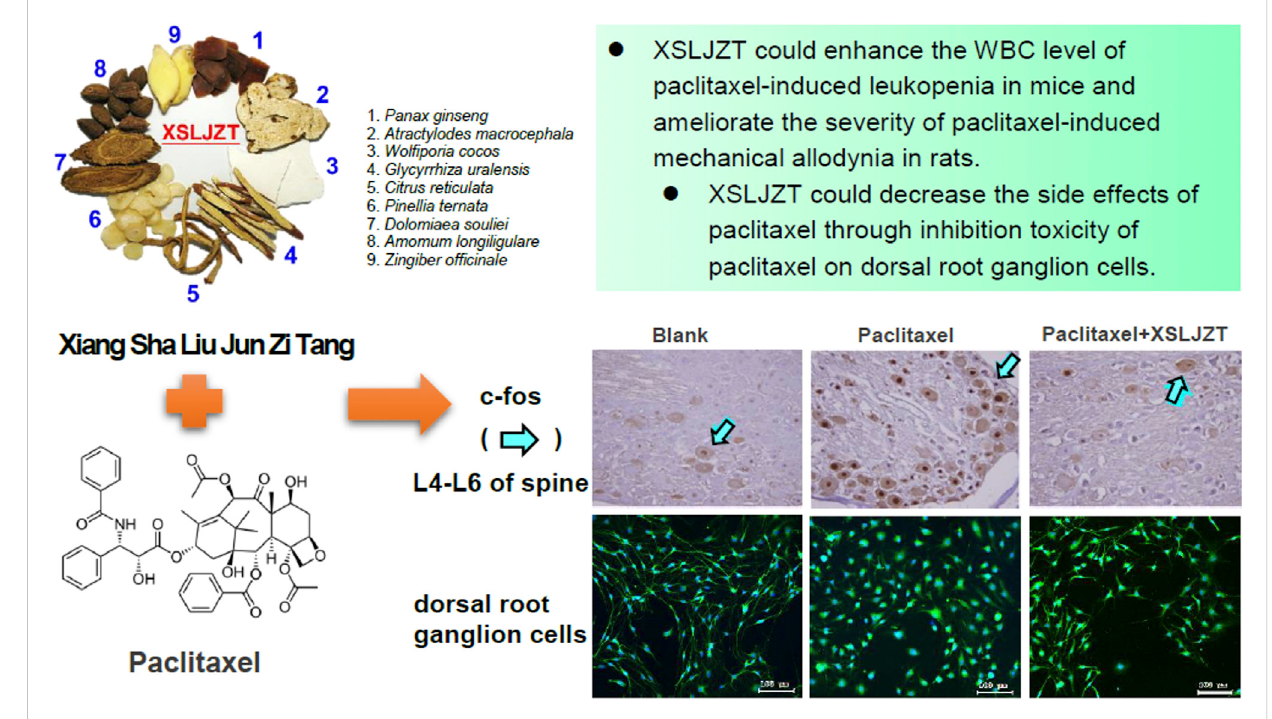
FIGURE 9 Summary of the XSLJZT on paclitaxel-induced leucopenia and